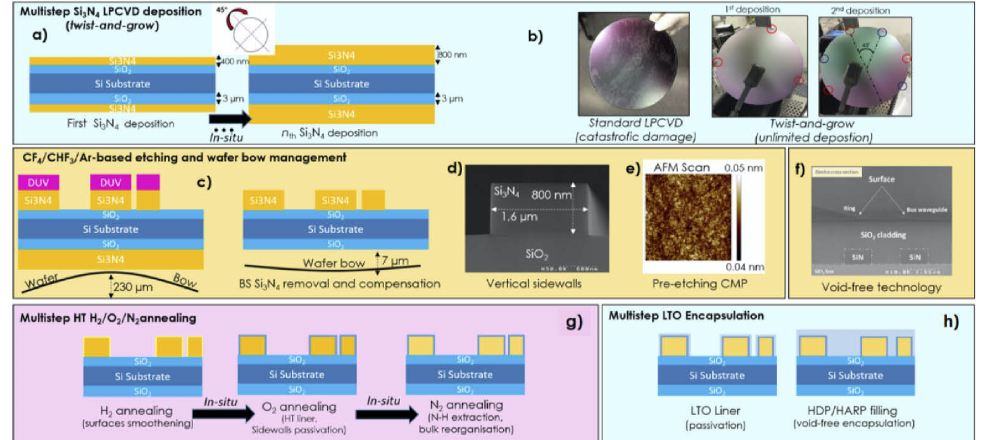
Figure 4. Schematics of the twist-and-grow and multiple-step chemical-physical annealing process: ( a ) twist-and-grow deposition of Si 3 N 4 , ( b ) images of the grown Si 3 N 4 with and without twist-and- grow, ( c ) fluorocarbon dry etching and wafer bow management, ( d ) example of a Si 3 N 4 waveguide with sidewall angle < 2deg after CMP, ( e ) AFM micrograph before CMP, ( f ) SEM cross-section of the encapsulated waveguides, ( g ) multistep H 2 /O 2 /N 2 in situ annealing and ( h ) multistep encapsulation. Reprinted with permission from [33], ©2019 The Optical Society.